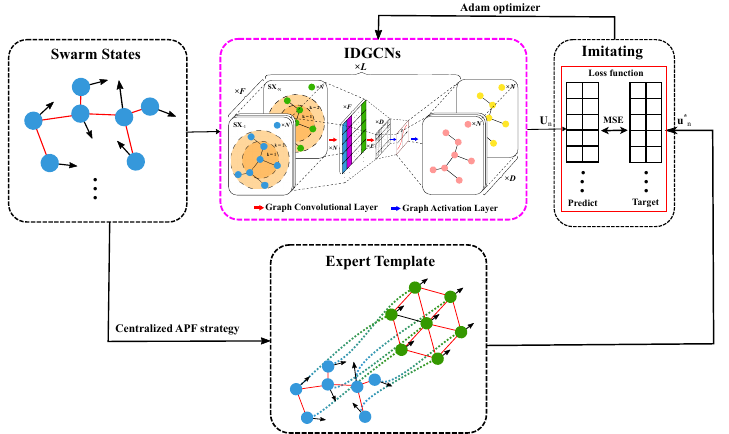
Figure 2. The framework of the proposed imitation learning method based on IDGCNs. The part in the pink box will become the distributed flocking control strategy we need by learning from the